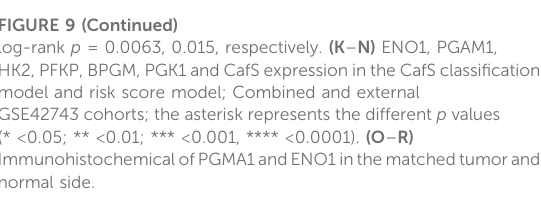
FIGURE 9 Relationship between CafS classi fi cation pattern and CAFs risk score model (A , B) The correlation between CafS and risk score in the combined and external cohort GSE42743; Combined, r = 0.14, p = 3.1e-05;GSE42743,r=0.5,p=7e-06. (C – F) CafSinthehighand low risk groups in the combined, TCGA-HNSC, GSE41613 and GSE42743 cohort p = 0.025, 0.012, 2.57e-06, 0.007, respectively. (G – J) Kaplan – Meiercurvesofoverallsurvivalaccordingtothemedian of ENO1 and PGAM1 expression in the Combined and GSE42743 external validation cohorts. Combined, ENO1 and PGAM1, log-rank p = 0.015, 0.035, respectively. GSE42743, ENO1 and PGAM1,